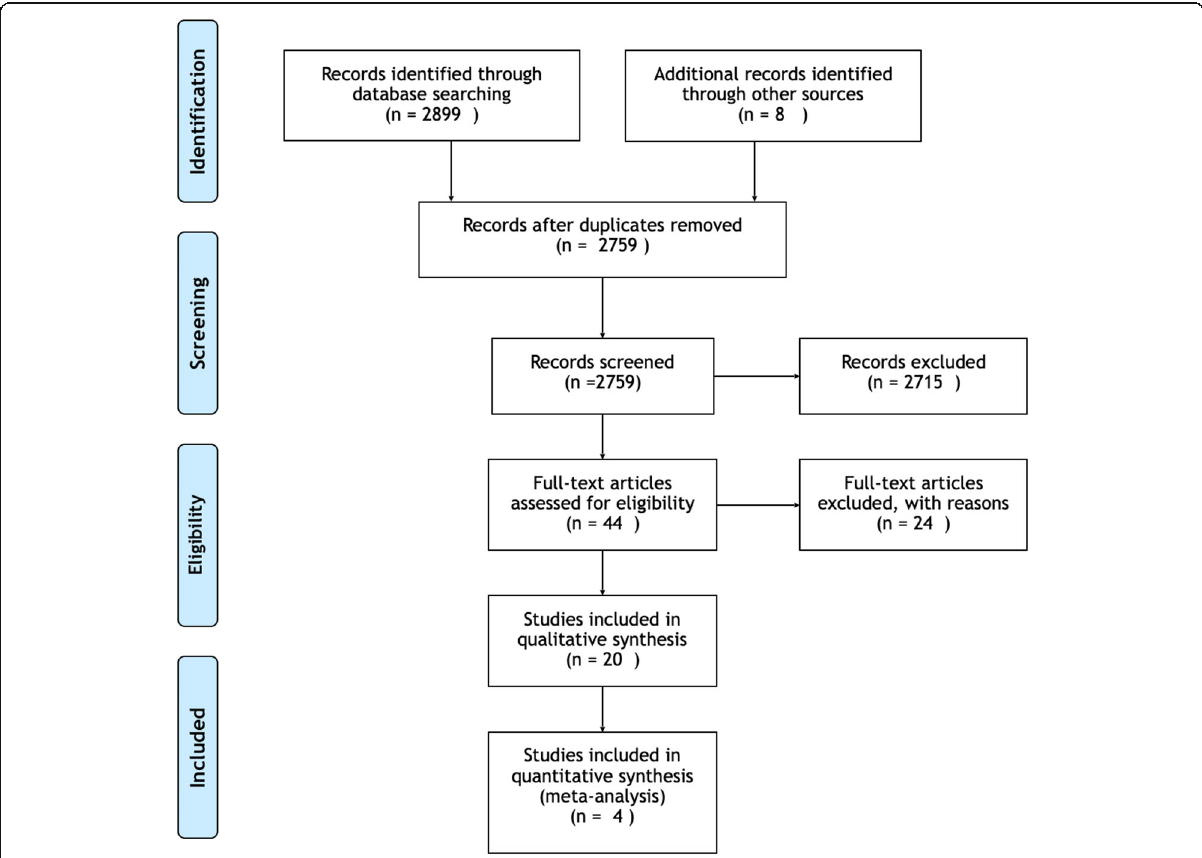
Fig. 1 PISMA flowchart of the screening